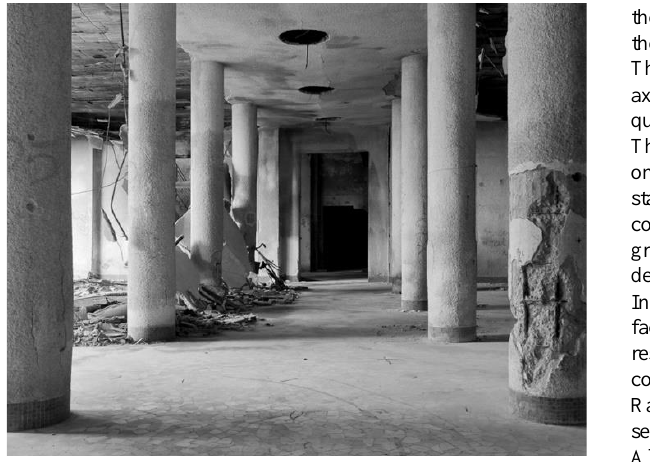
Figure 6 . Varese Colony in 2022.